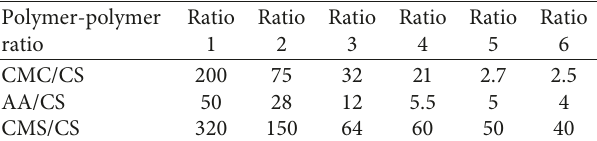
Table 1: Relation between anionic and cationic components for the different polymer